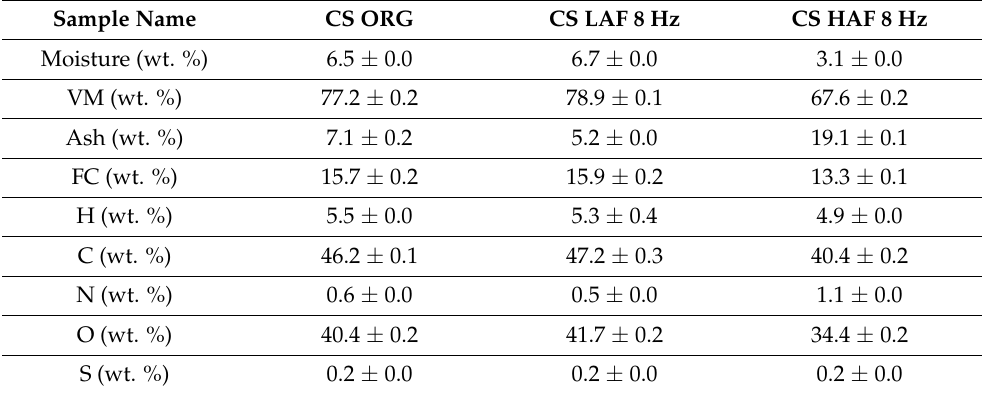
Table 1. Proximate and ultimate analysis of ORG and separated CS. Measurements made using ASTM D7582, ASTM D5373, and ASTM